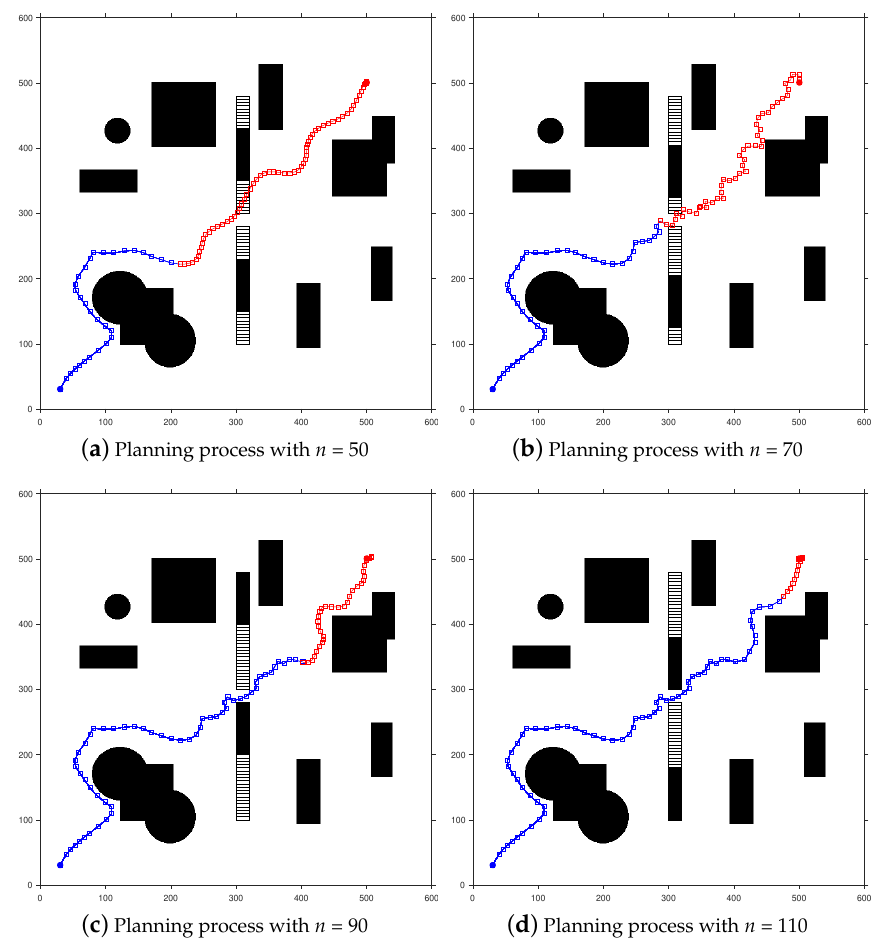
Figure 4. The process of exploring a path on a simulative map with dynamic